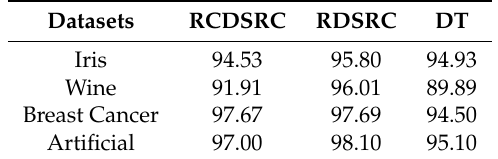
Table 4. Average accuracy.